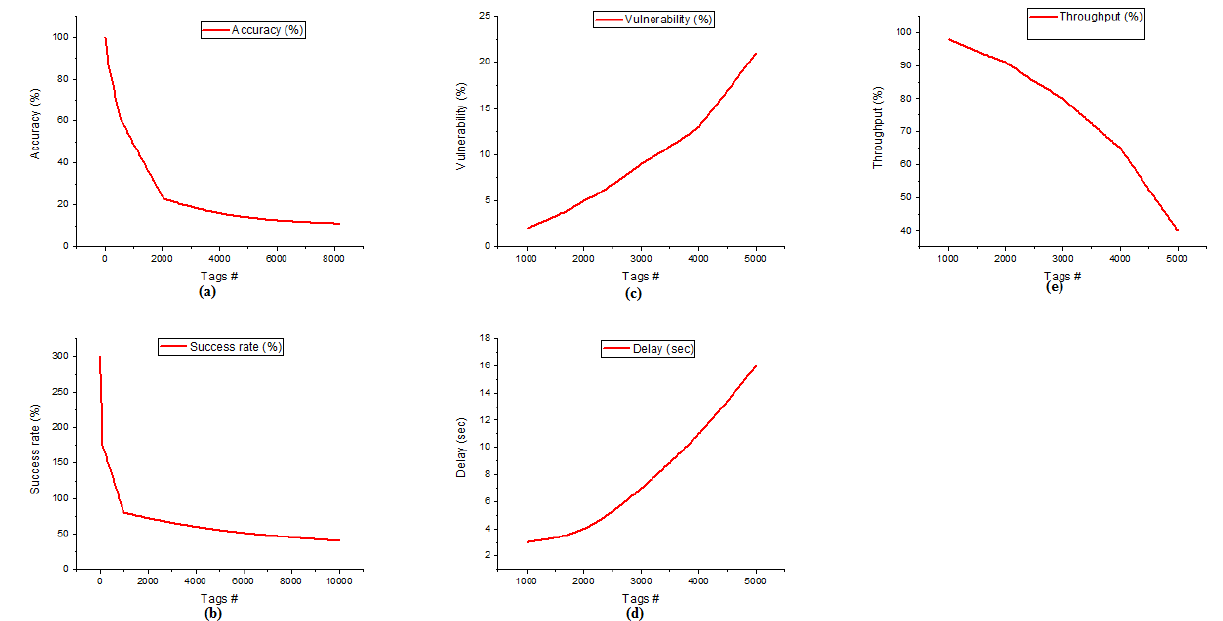
Figure 3. ( a ) Accuracy of Clustered RFID ( b ) Success rate of Clustered RFID ( c ) Vulnerability of Clustered RFID ( d ) Delay of Clustered RFID ( e ) Throughput of Clustered RFID. Clustered RFID ( d ) Delay of Clustered RFID ( e ) Throughput of Clustered